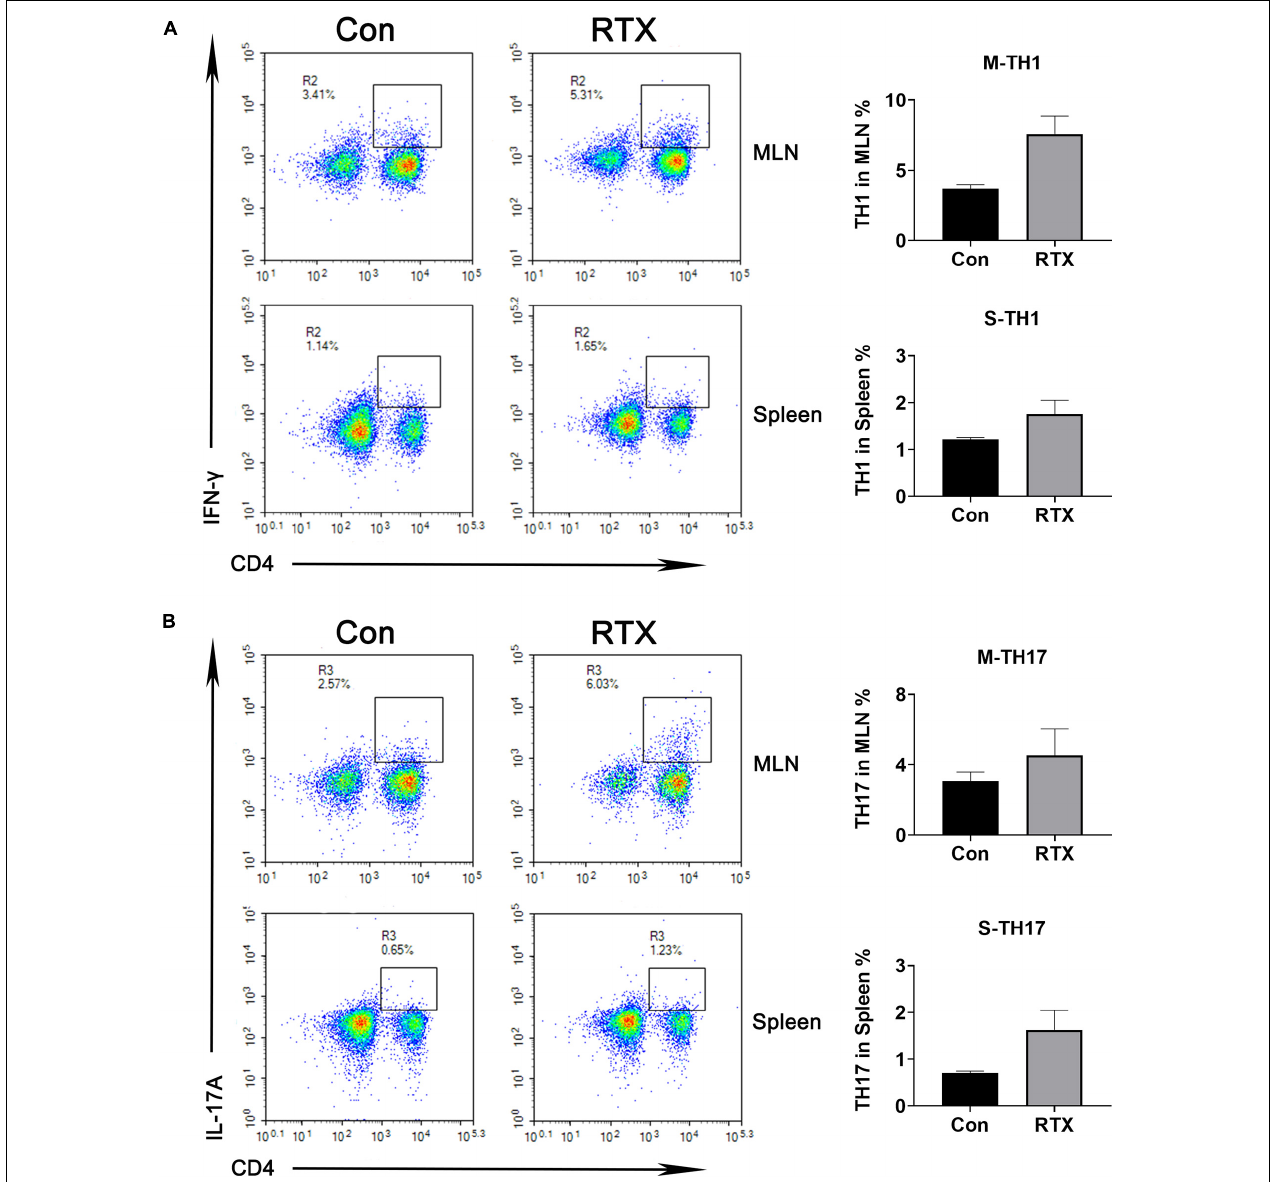
FIGURE 2 | Changes in helper T (Th) cell subsets are induced by RTX. The percentages of Th1 and Th17 cells in the spleen and MLN were detected by flow cytometry. Data are expressed as the mean ± SEM. p <